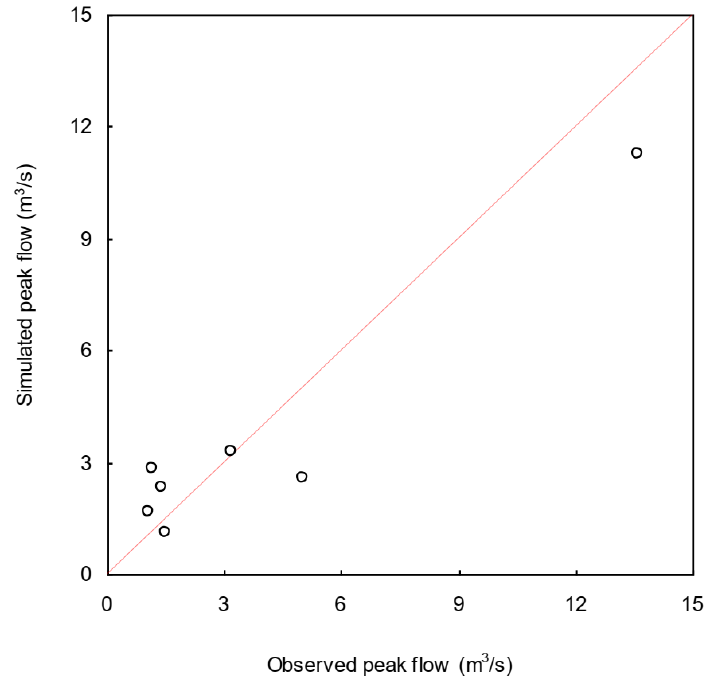
Figure 5. Scatterplot of the observed vs. simulated peak flow events in the Duverso torrent (Calabria, Southern